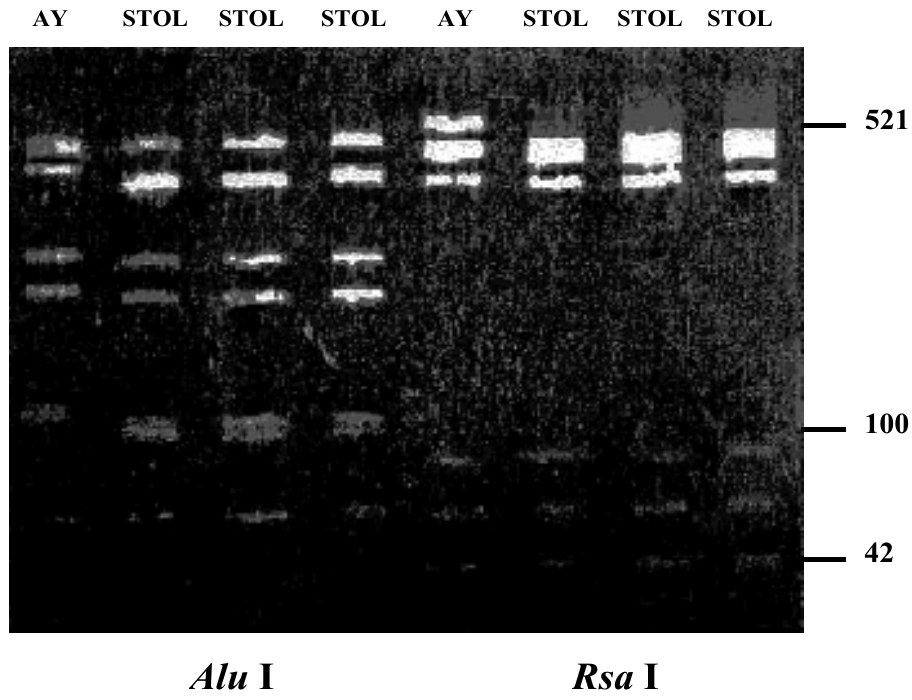
Fig. 2. Alu I (A) and Rsa I (B) restriction banding patterns of polymerase chain reaction amplified rDNA (with prim- ers P1/P7) of tomato big bud (group I) and stolbur phytoplasmas (group XII) in naturally infected tomato plants. AY = aster yellows phytoplasma (tomato big bud), STOL =